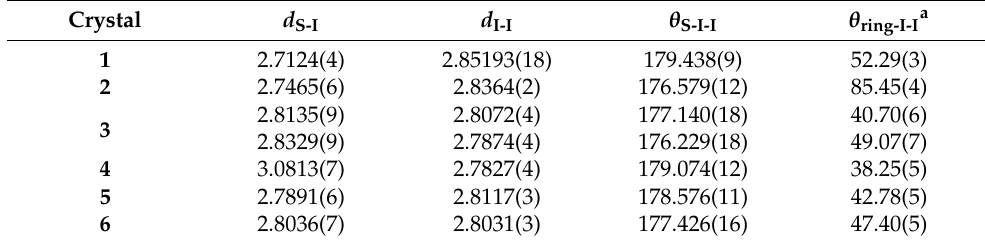
Figure 2. Single molecules of 1 ( a ), 2 ( b ), and 3 ( c ), arranged to show position of S-I-I relative to dithiane ring plane. Hydrogen atoms have been omitted for clarity. Atomic displacement ellipsoids are shown at the 50% probability level. Table 1. S···I - I interaction distances (Å) and angles (°).